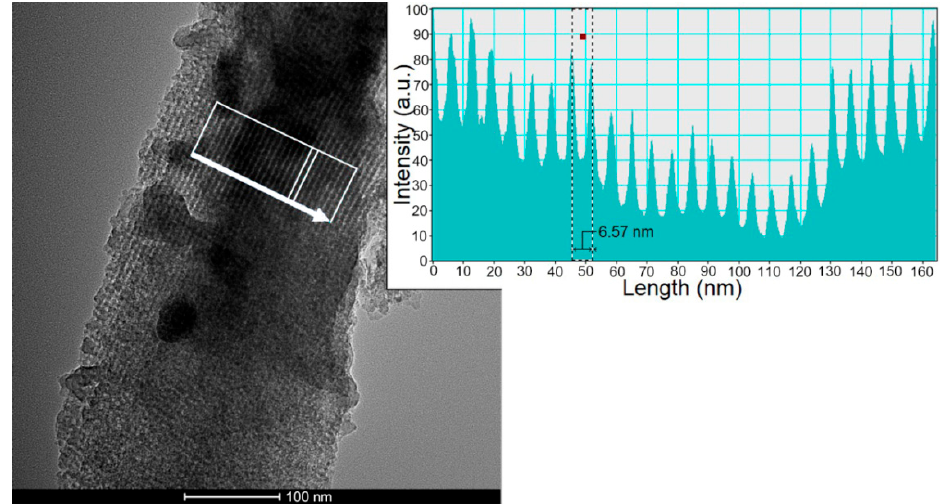
Figure 3. Pore size determination of an ordered MSG.